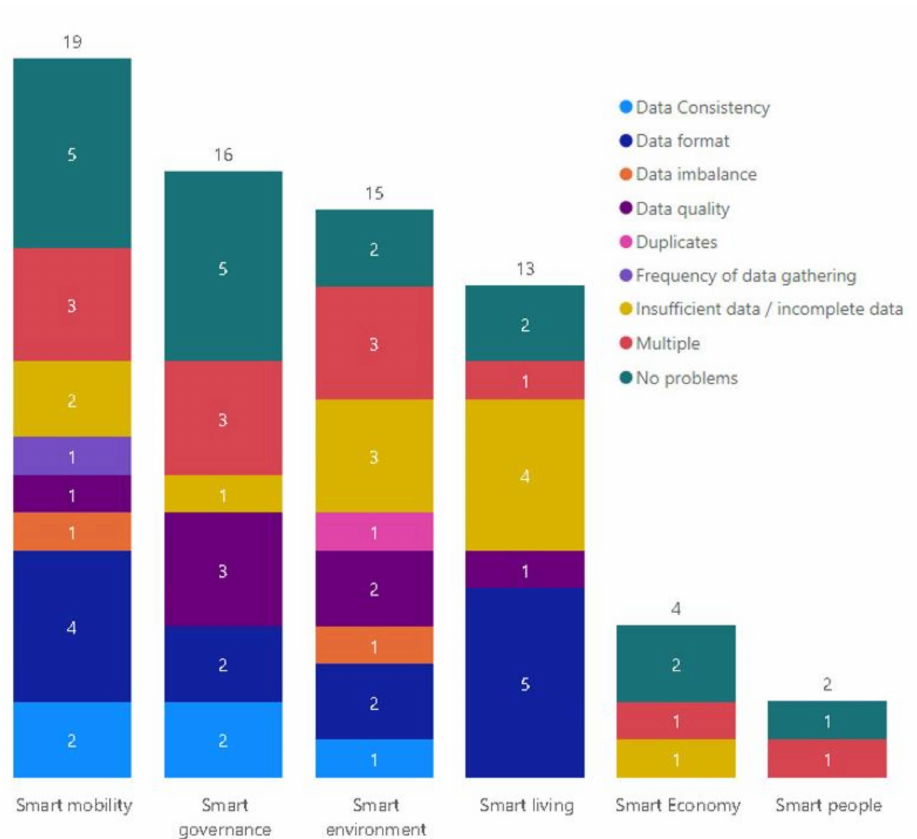
Figure 18. Challenges in open data utilization for each of the SC areas of the